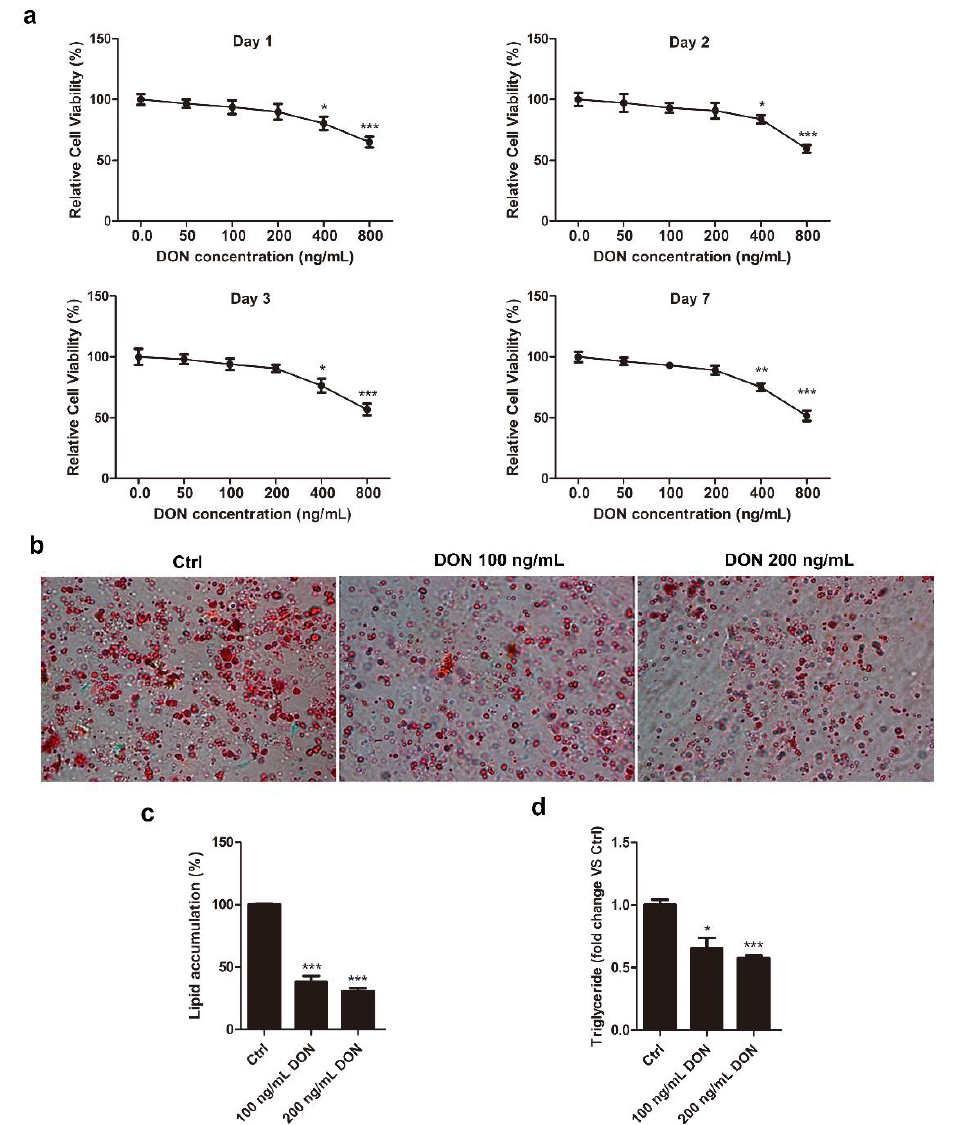
Figure 1. E ff ect of DON on adipogenesis in 3T3-L1 cells. ( a ) Cytotoxicity of DON in 3T3-L1 cells. The e ff ect of DON on metabolic activity was examined by the CCK-8 assay. 3T3-L1 preadipocytes were treated with 0, 50, 100, 200, 400, or 800 ng / mL DON for 1, 2, 3, or 7 d, respectively. The values are expressed as percentages of control responses and were obtained from three independent experiments with six replications. ( b ) Lipid accumulation was visualized and quantified by Oil Red O staining. The cells were photographed at × 100 magnification, and morphological changes were assessed based on lipid accumulation with or without DON (100 and 200 ng / mL) on Day 7. ( c ) 3T3-L1 cells were treated with isopropanol, and lipid accumulation was measured according to the absorbance at 510 nm. Lipid accumulation in the control group cells was compared to that in the DON-induced cells. ( d ) DON inhibited TG accumulation in 3T3-L1 cells. 3T3-L1 preadipocytes were cultured in DMEM + FBS medium containing the di ff erentiation cocktail, with or without DON (100 and 200 ng / mL) for 7 days. The results are representative of three independent experiments, and statistical significance is indicated by * p < 0.05, ** p < 0.01, *** p < 0.001.